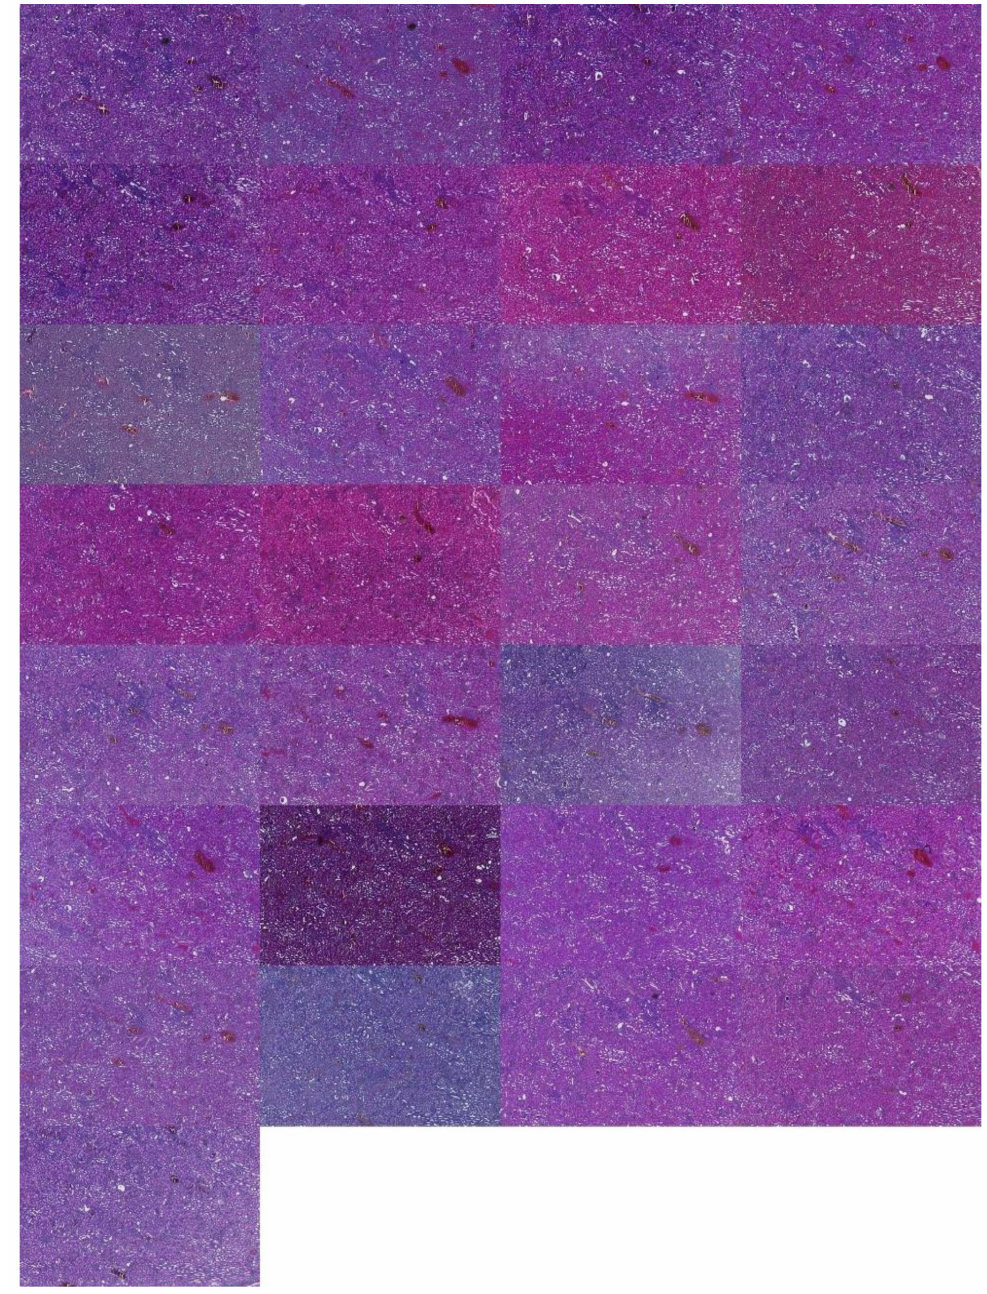
Figure A6. Kidney examples visualized by descending silhouette score within the second cluster found (C2). Silhouette values descend in the left direction from the left-most example in the first